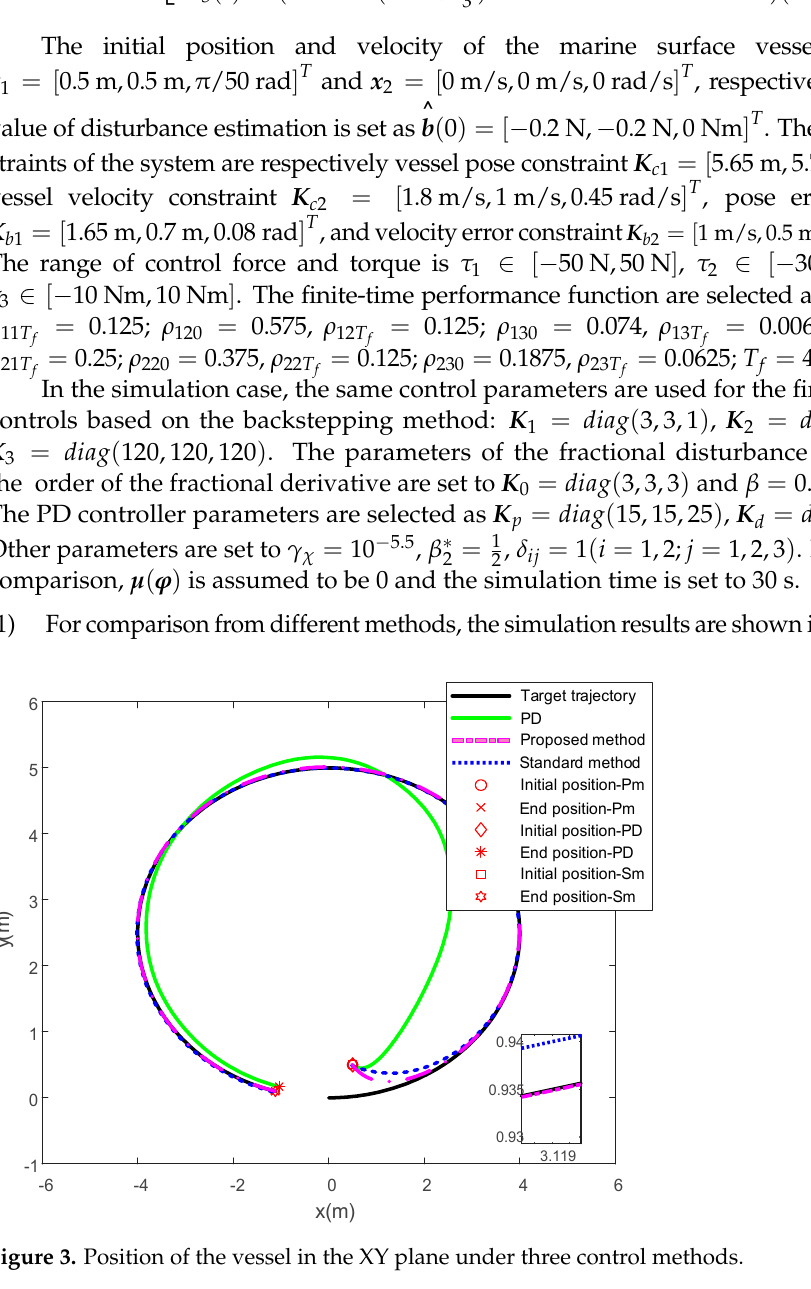
) x 13 (r ad Figure 4. Pose tracking of the vessel under three control methods.